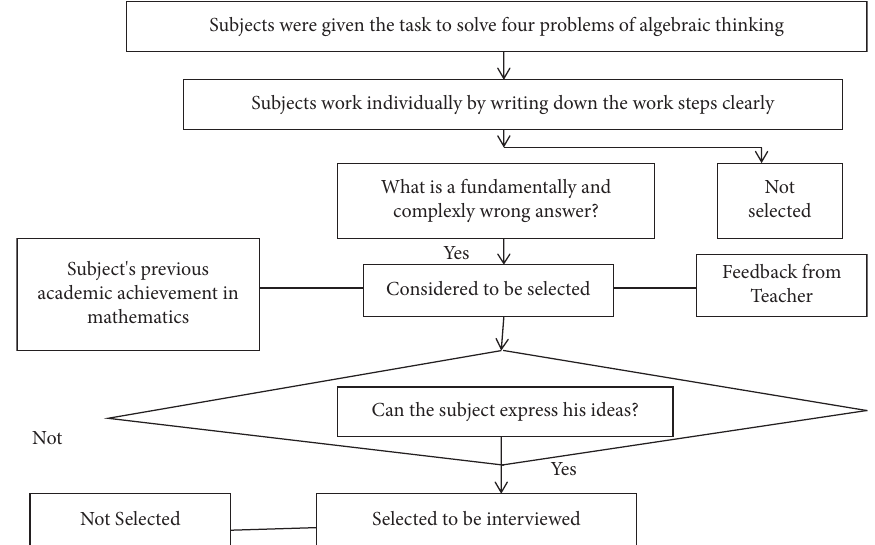
Figure 1: Chart of research subject determination for